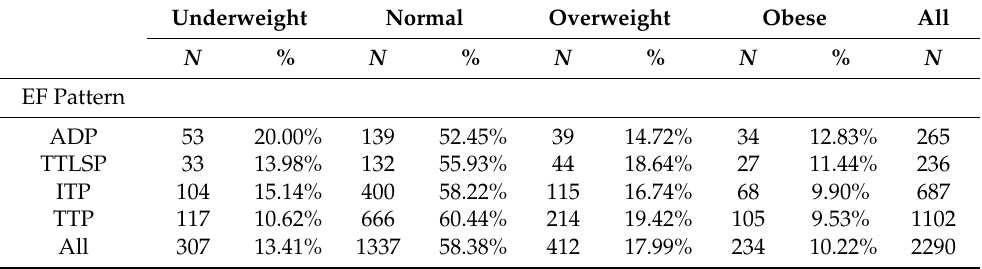
Table 2. Differences in body mass index (BMI) distribution among eating frequency (EF) patterns.